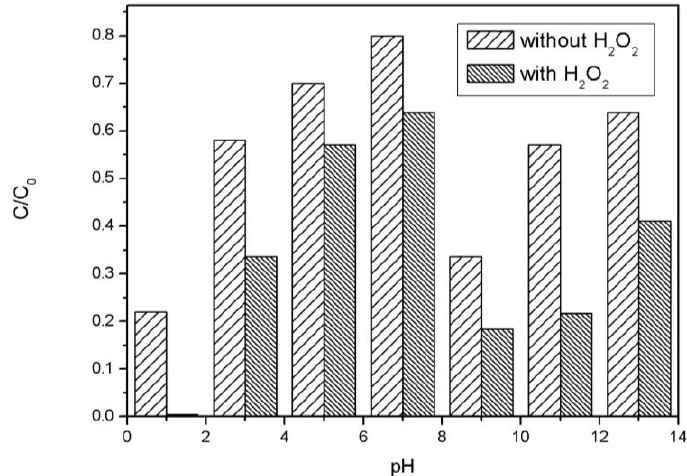
Figure 9. Effect of pH on catalytic oxidation of AO7 [ C (AO7) = 5.00 × 10 −5 mol/L, C (H O ) = 4.85 × 10 −2 mol/L, C (CoTCPcNa-AN-CNFs) = 0.667 g/L, 25 °C] after 1 2 2